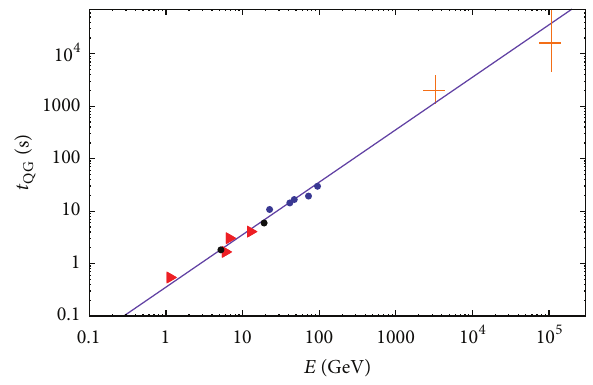
Figure 16: We here show in a logarithmic plot a straight line with the slope we determined in Section 3. Also shown (as thick points) arethe7datapointsforGRB130427AalreadyshowninFigure 4.The red triangles describe data on four events found on a single spectral- lag straight line in Figure 10 for GRB080916C. The orange point with sizable error bars are for the 3.3 TeV neutrino and the 109TeV neutrino discussed from our perspective in [32], with 30 percent uncertainty on neutrino energies reflected in horizontal segments and vertical segments reflecting the uncertainty in redshift of the GRB possibly associated to the two